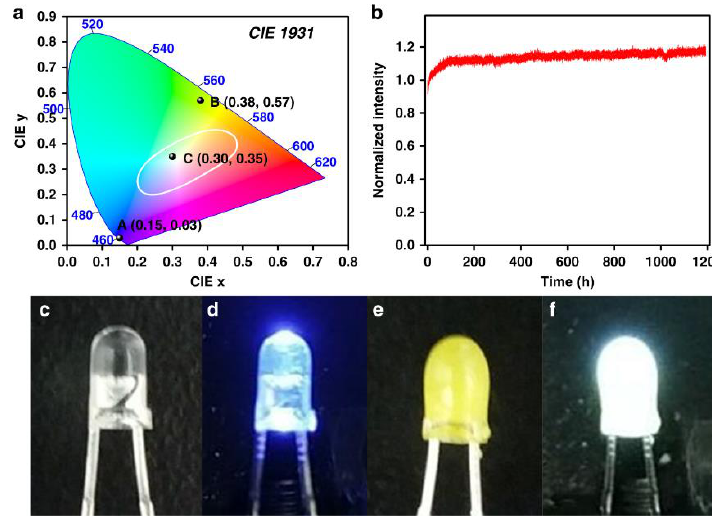
Figure 13. ( a – f ) A 3D-TPE-COF for white LED [50].